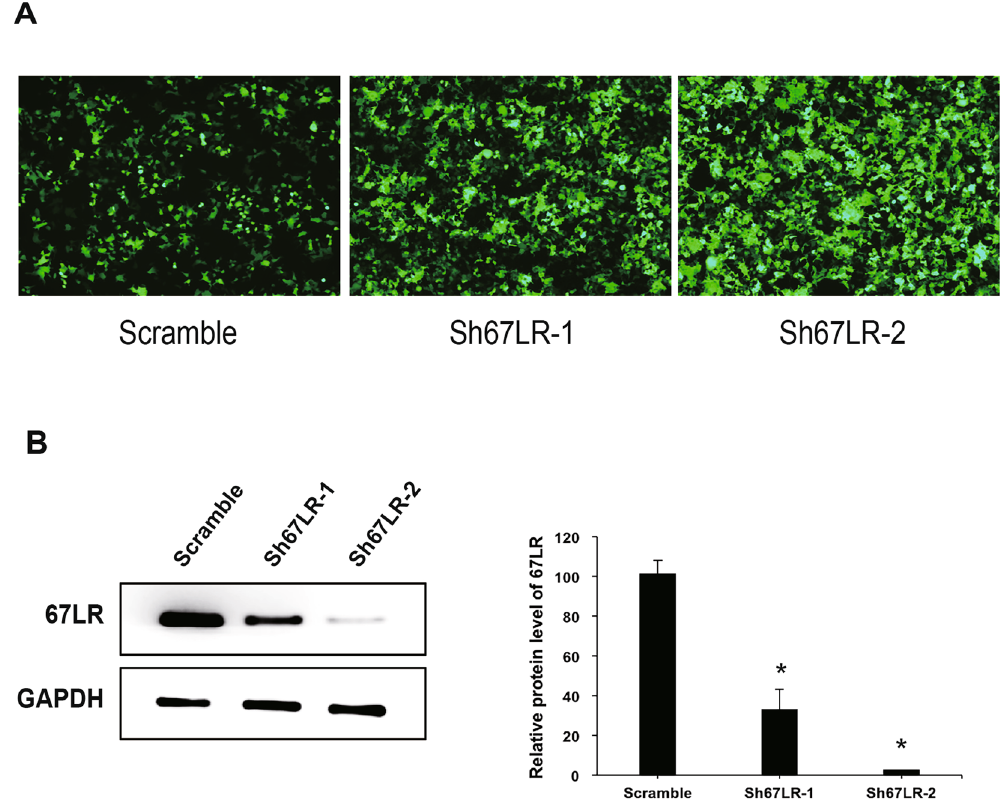
Figure 5. The efficiency of shRNA silencing of 67LR. ( A ) Transfection efficiency in 293 T cells. ( B ) Western blot analysis showing the expression of 67LR after silencing by shRNA plasmid. * p < 0.05 vs. Scramble